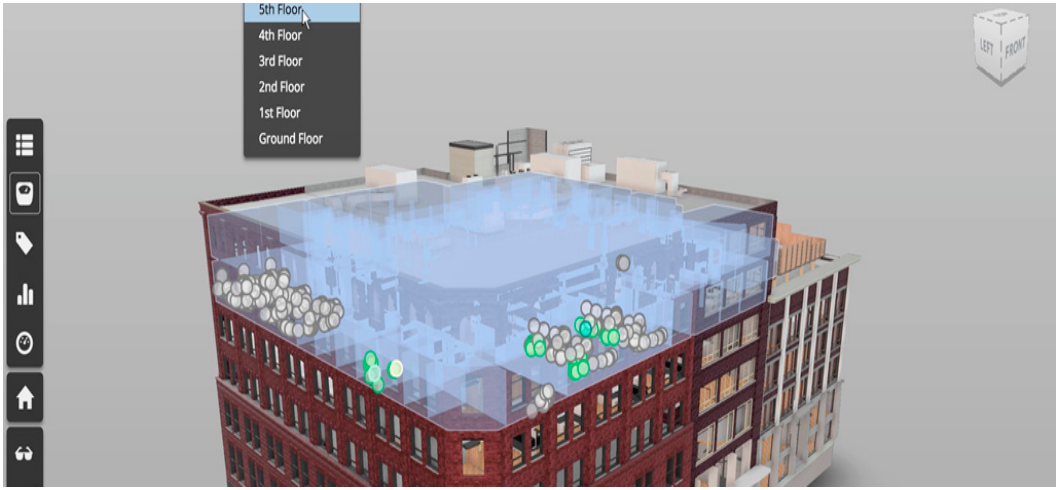
Figure 2. User interface for Forge Viewer .